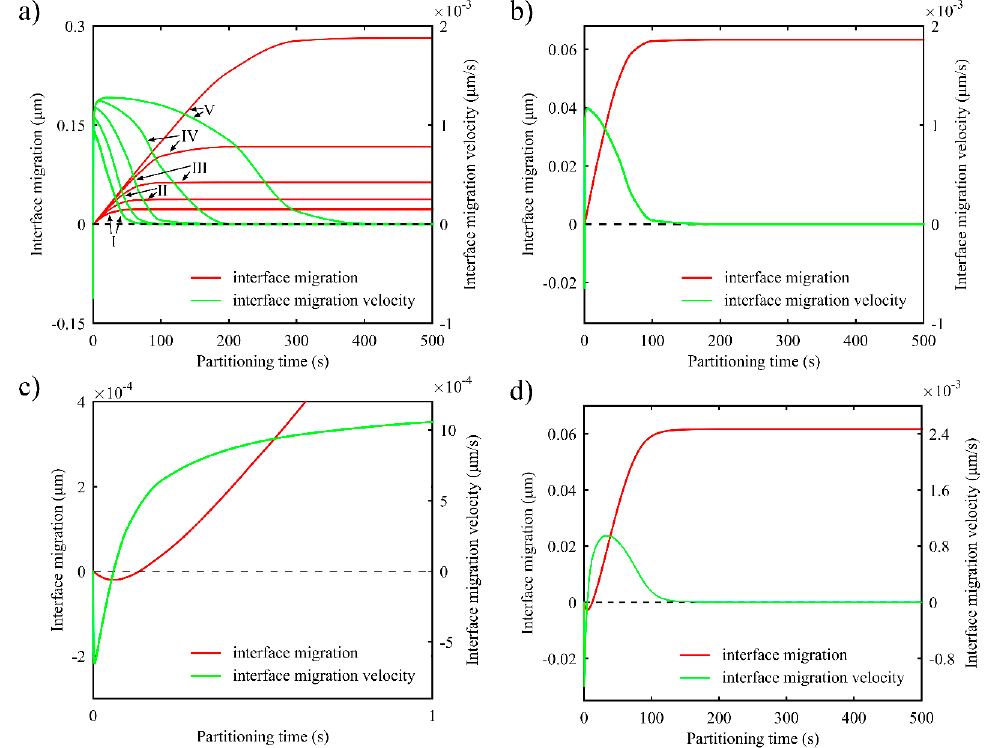
Figure 12. Evolution of interface migration and interface migration velocity during the first process (two-stage Q-P process). The positive direction of the interface migration points from martensite to austenite. ( a ) The evolution during partitioning at 425 ◦ C for 500 s after quenching to different first quenching temperature: I: T Q1 = 250 ◦ C; II: T Q1 = 275 ◦ C; III: T Q1 = 300 ◦ C; IV: T Q1 = 325 ◦ C; V: T Q1 = 350 ◦ C; ( b ) The evolution during partitioning at 425 ◦ C for 500 s when T Q1 = 300 ◦ C; ( c ) Detailed evolution in the first second when T Q1 = 300 ◦ C; ( d ) The evolution when partitioning temperature rises from 300 ◦ C to 425 ◦ C in 160 s according to the formula T P 1 = 125 ( t /160 ) 1/3 + 300, the partitioning temperature is kept for 500 s, and T Q1 = 300 °C.